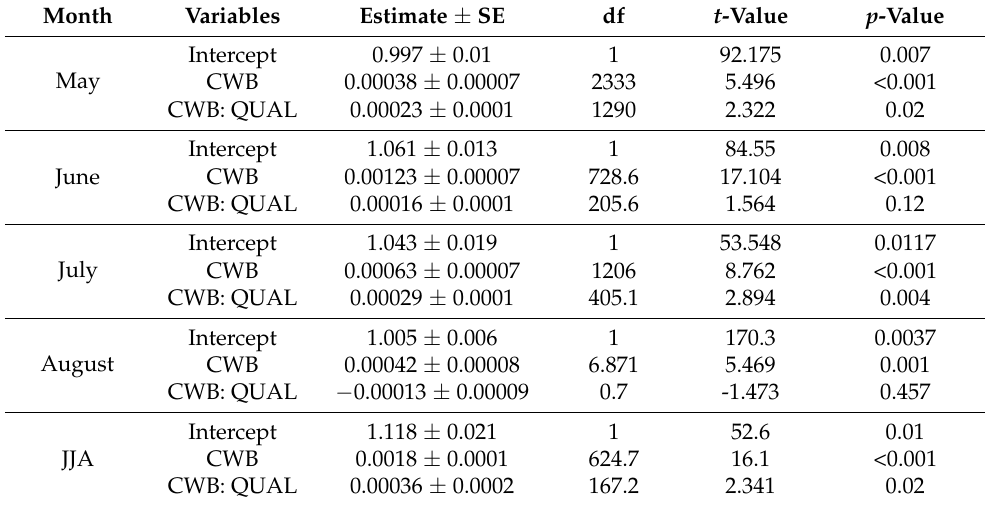
Table 2. The linear mixed models showing the fixed effect estimates, standard error (SE), and degree of freedom (df) when analyzing the relationship between monthly climatic water balance (CWB) and the standardized growth of co-occurring Carya ovata and Quercus alba (QUAL) over 1908–2011 at 15